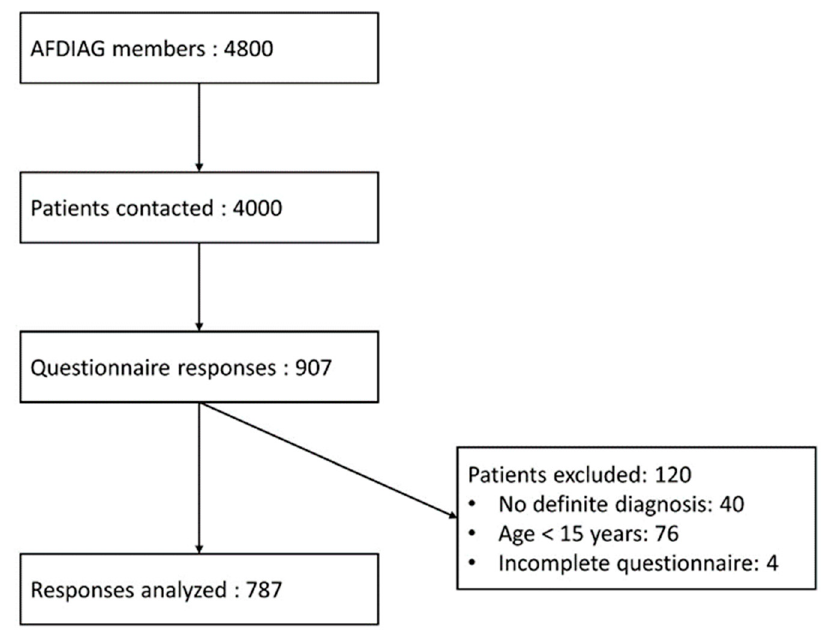
Figure 1. Flow chart. Table 1. Patient and disease characteristics.